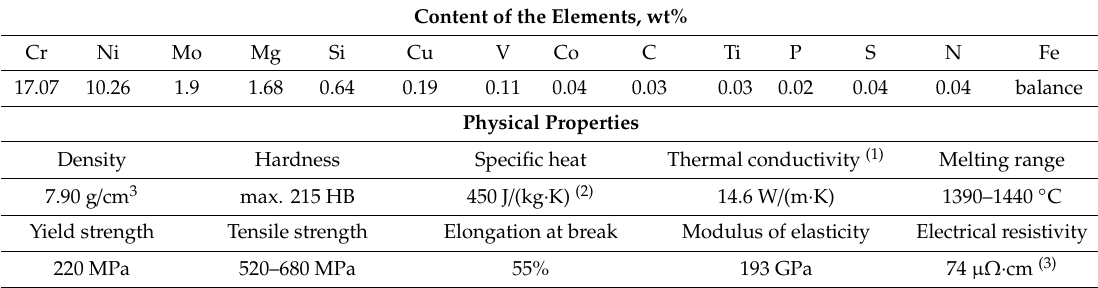
Table 1. Chemical composition and physical properties of AISI 316L stainless austenitic